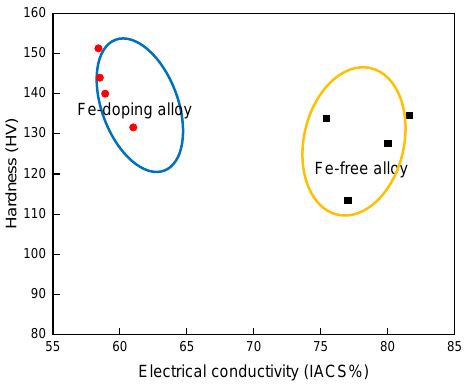
Figure 10. The relationship of hardness and electrical conductivity of Fe-free and Fe-doping alloys.